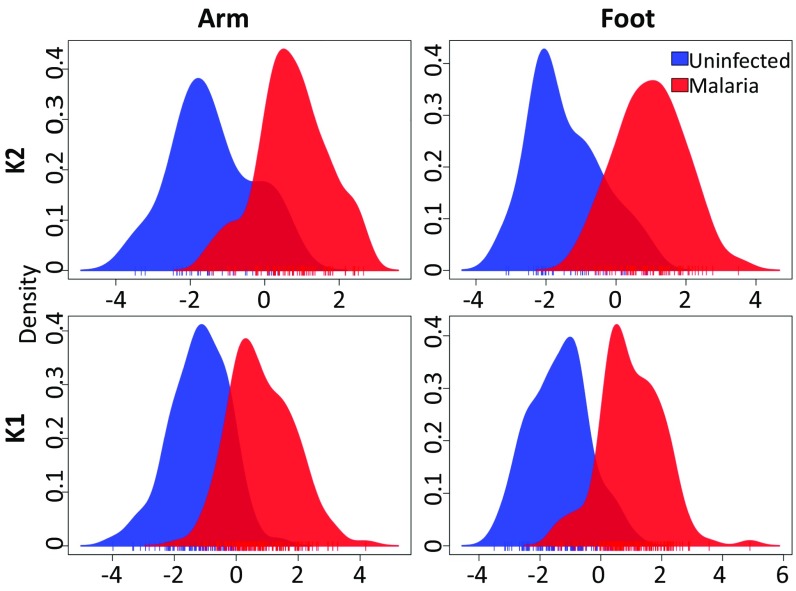
Group separation using DAPC reveals differences between malaria-infected (asymptomatic + symptomatic) and uninfected individuals in foot and arm volatiles for datasets K1 and K2. Vertical lines beneath the x-axis represent individual samples.